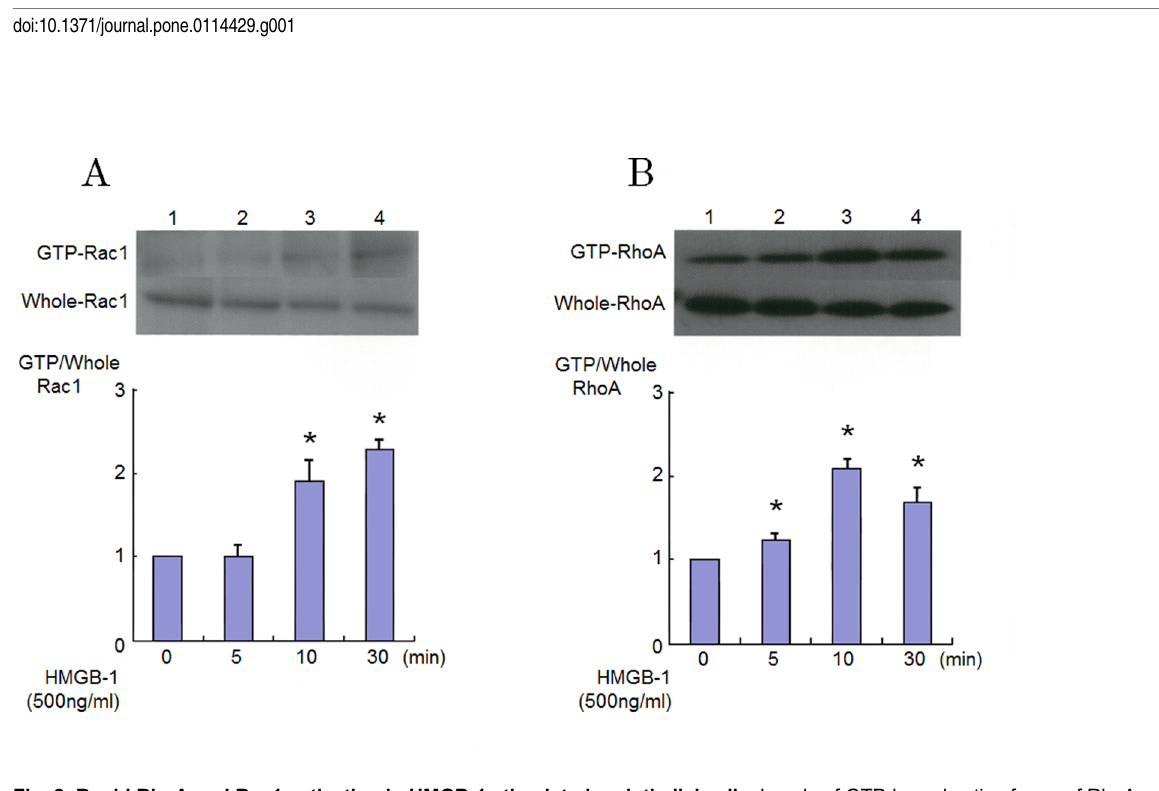
PLOS ONE | DOI:10.1371/journal.pone.0114429 December 9,